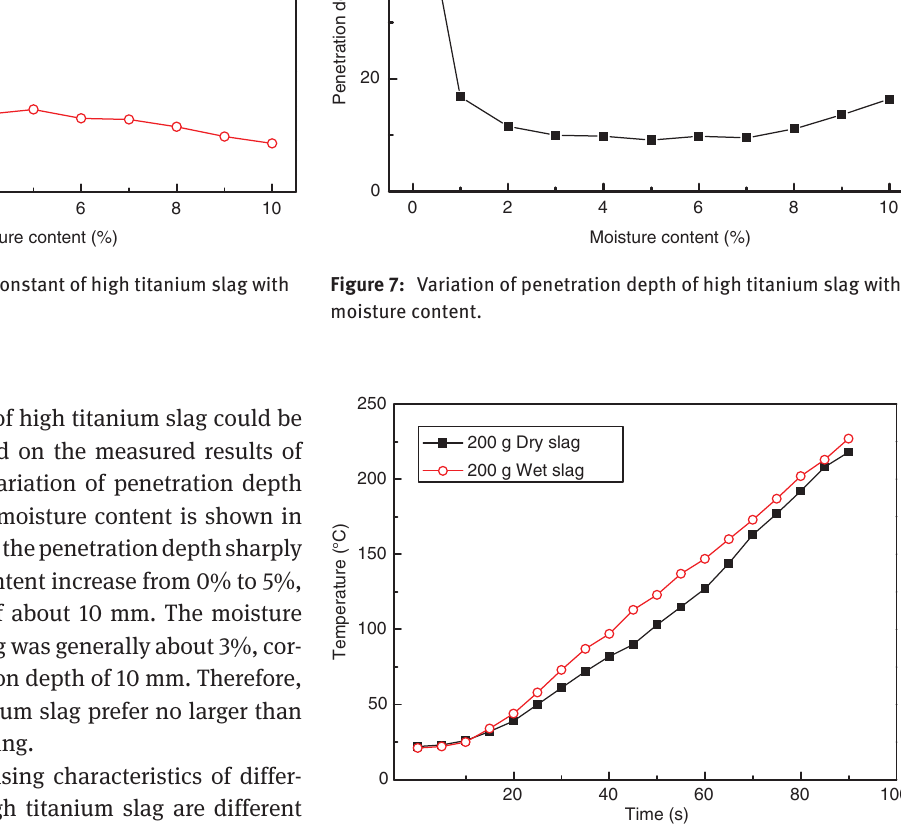
Figure 8: Heating rate curves of dry and wet high titanium slag in microwave